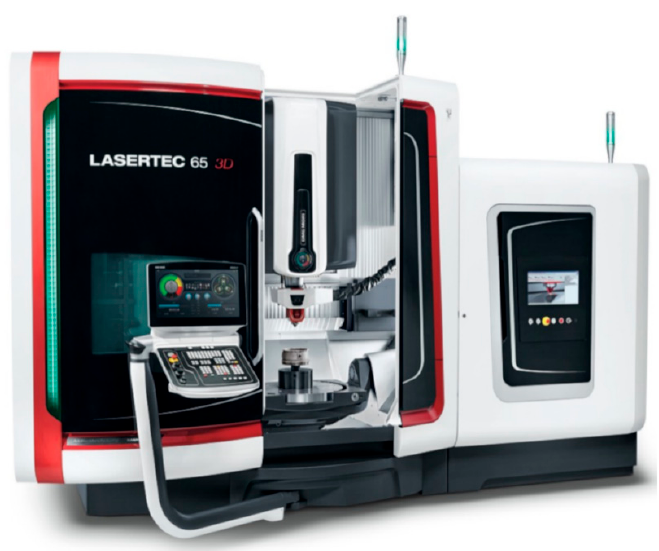
Figure 1. DMG MORI Lasertec 65 3D hybrid machine.